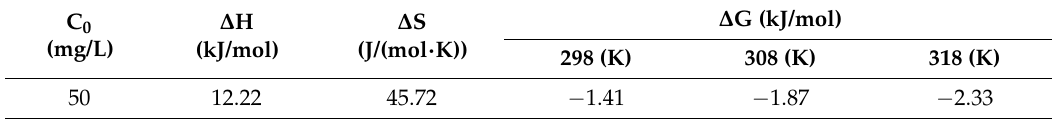
Table 3. The thermodynamic parameters for PRO adsorption onto ATP/Fe 3 O 4 /GO.